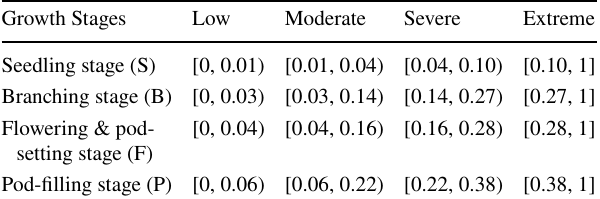
Table 9 Drought loss vulnerability levels of soybean for four growth stages in the Huaibei Plain study area in Anhui Province, China Growth Stages Low Moderate Severe